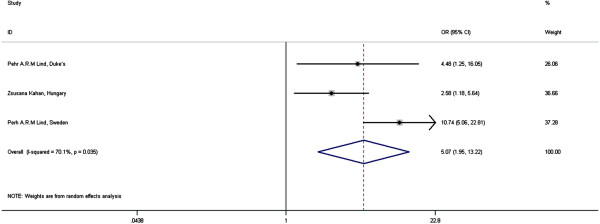
Meta-analysis: Effect of SCF irradiation on RP in 3D-CRT for BC.